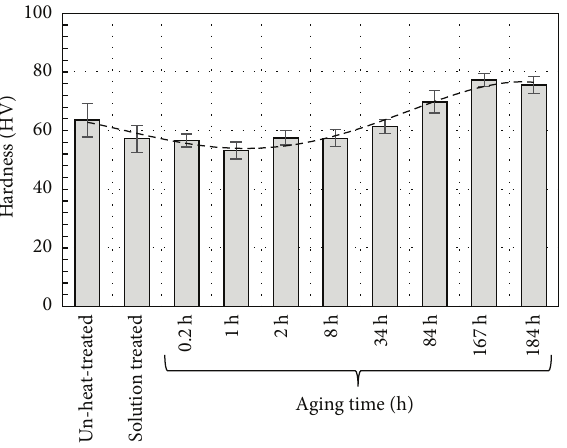
Figure 8: Measured hardness values of AZ61 alloy.